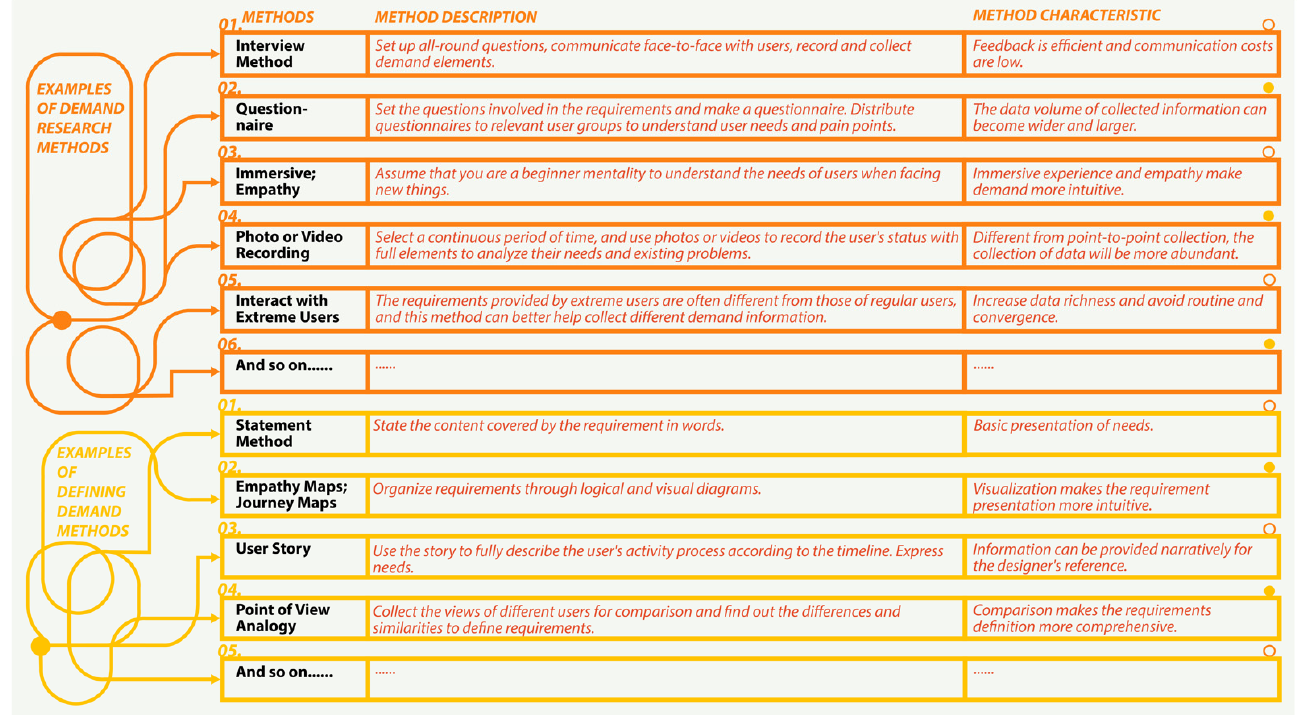
Figure 15. Examples of ideate methods.